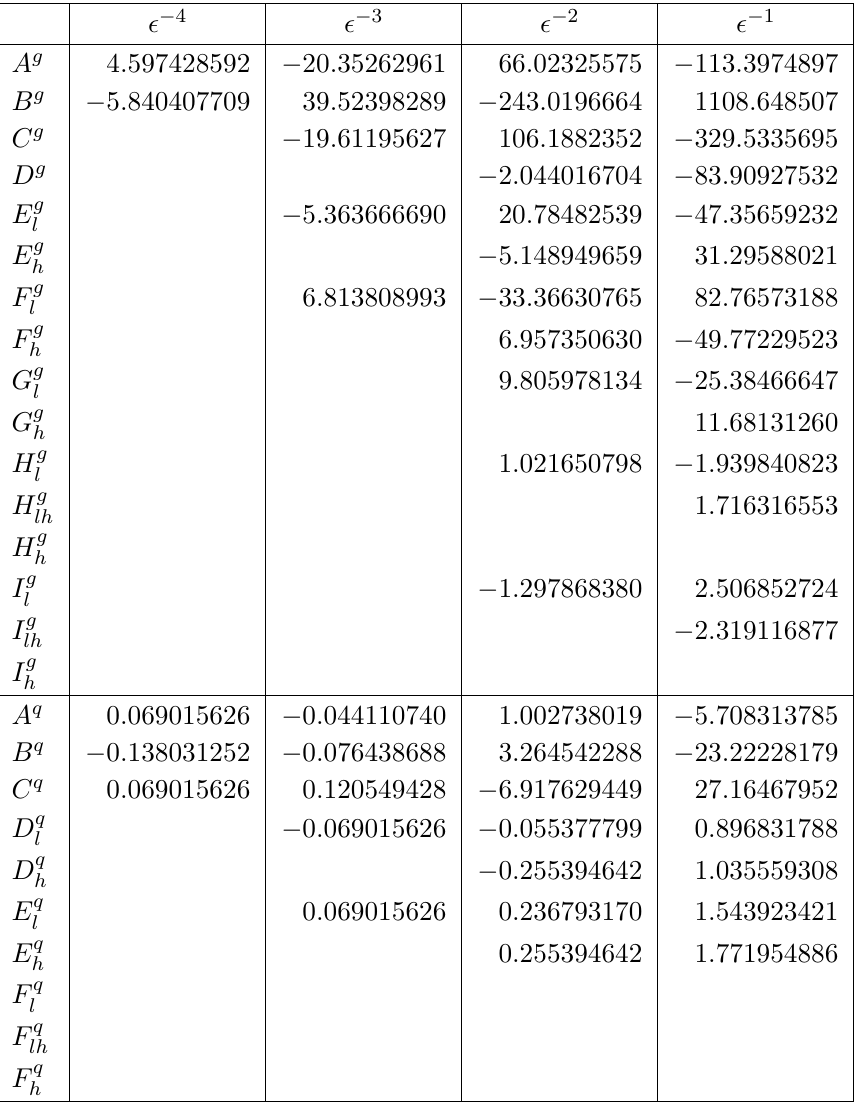
Table 3 . IR poles decomposed as color coefficients for the phase-space point x 12 = 130 , x 13